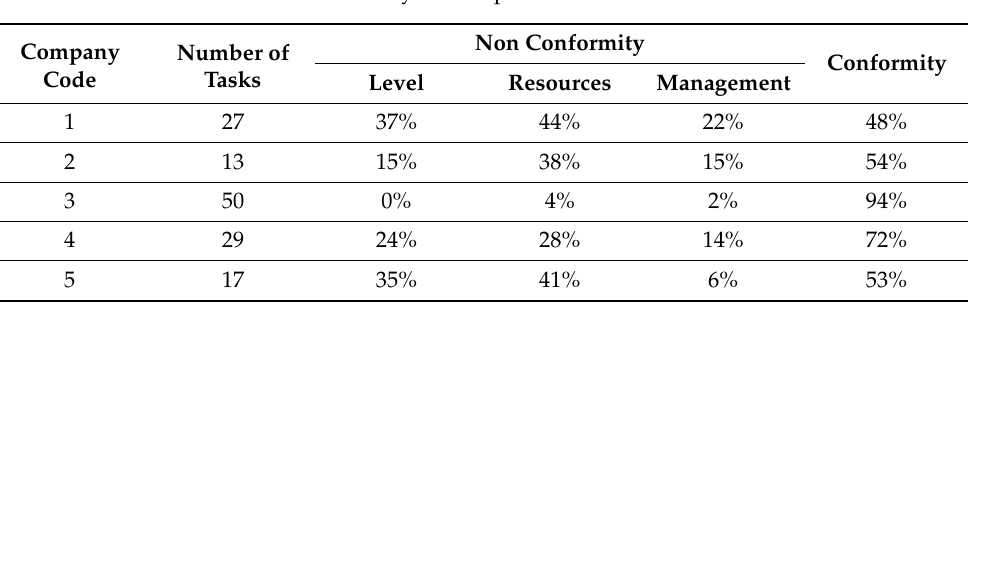
Table 6. Evaluation of the tasks conformity at